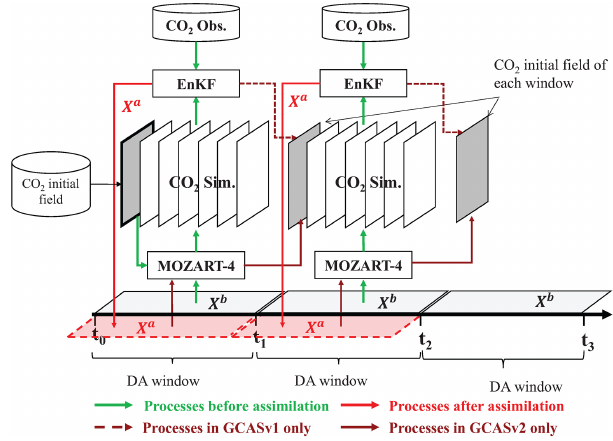
Figure 1. Flow chart of the GCASv2